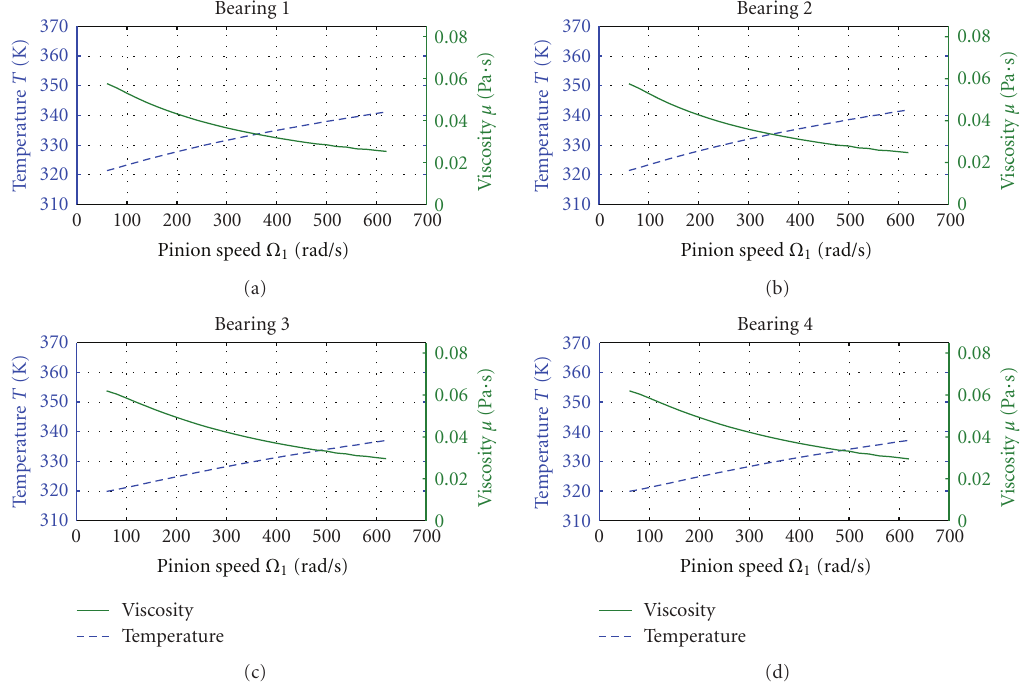
Figure 8: Variations of the bearing viscosities and temperatures with the input speed (spur gear se) C r = 1540 N · m, 50rad/s < Ω 1 <